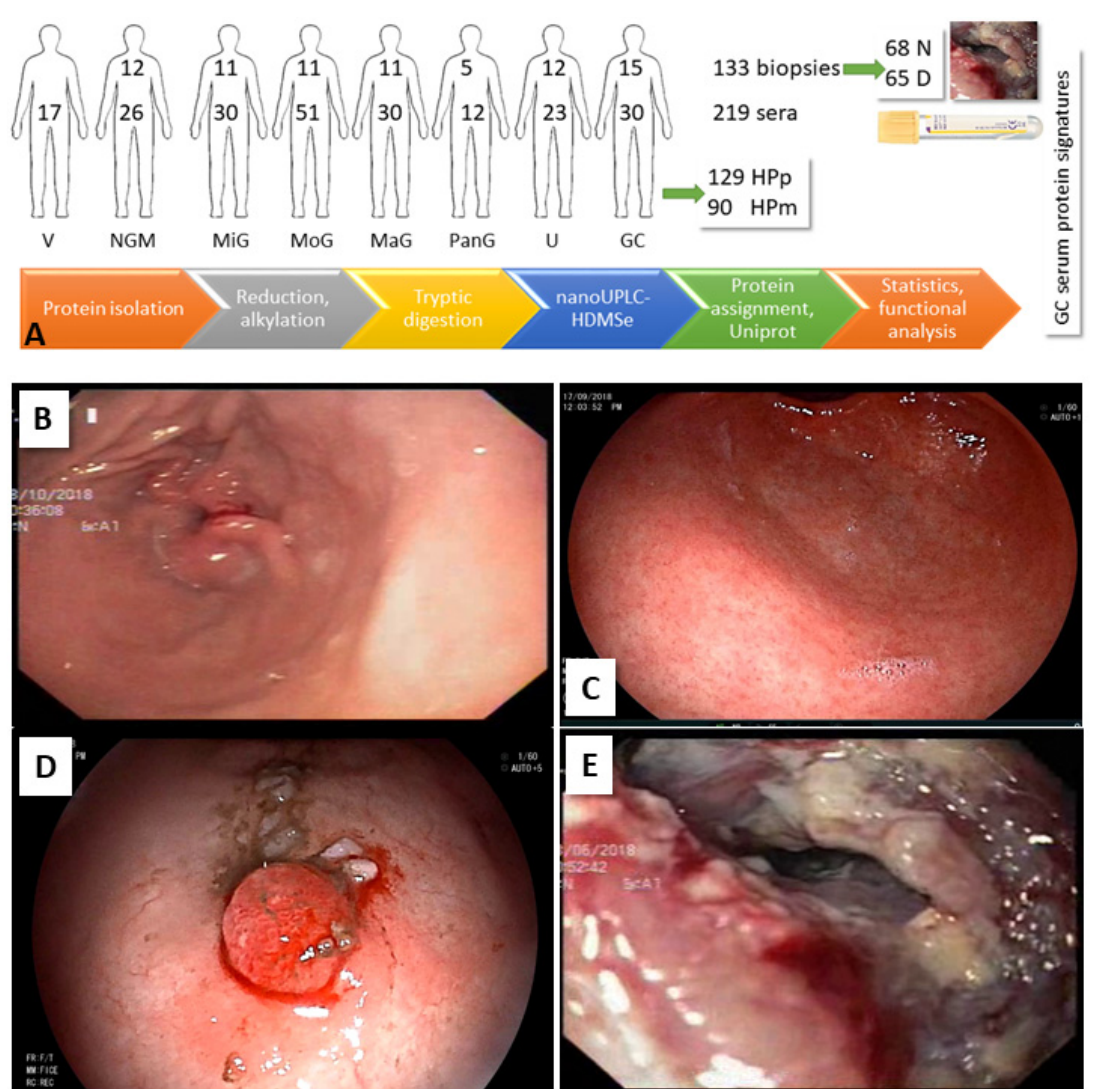
Figure 1. Experimental design and workflow for the elucidation of a GC serum protein marker profile. ( A ) Biopsies (133, 68 N site, 65 D site) and sera (219) were collected. More than half of the probands were H. pylori positive (59%). Proteins were isolated, trypsinized, and subjected to data-independent MS. Proteins were assigned, and the differences between disease groups were determined considering gender, infection status, and biopsy site, followed by functional classification and network analysis. ( B – E ) HPp patients with different gastroduodenal clinical manifestations. ( B ) NGM (no inflammation in antrum), ( C ) severe antral gastritis, ( D ) polyp (1st stage GC), ( E ) GC (differentiated adenocarcinoma).